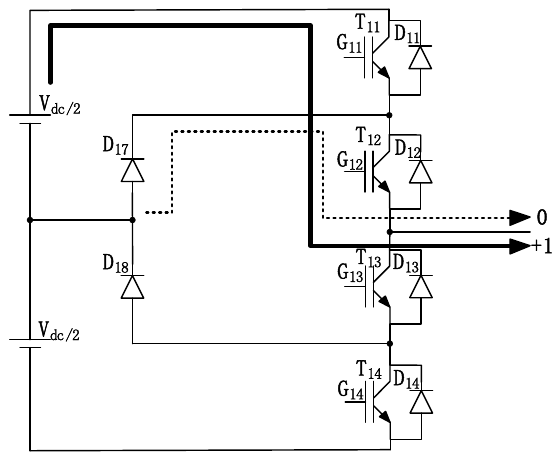
Figure 3. D1 type ( α = +1, M ≈ 0).